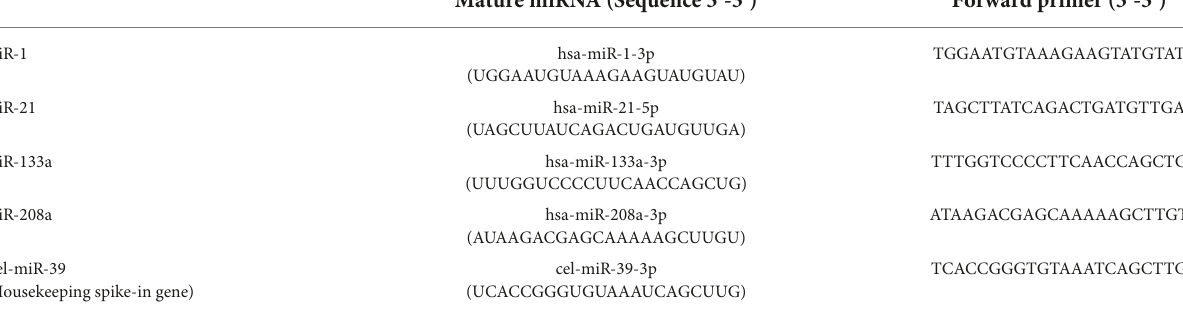
TABLE 2 Mature miRNA sequences analyzed in this study and related forward primers employed for qPCR. All primers were obtained from Sigma and employed at 500- µ M